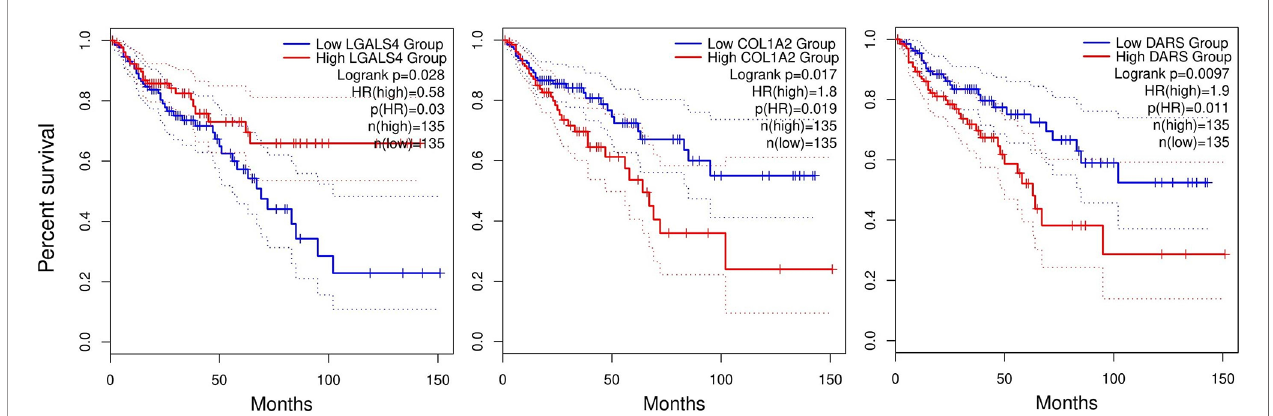
FIGURE 8 | Survival plots. Plots present the monthly survival rate of patients having high expression, red line, or low expression, blue line, of a speci fi c gene. Patients having high expression of LGALS4 had higher survival rates compared to patients having low expression of LGALS4. Contrary, patients having low expression of COL1A2 and DARS genes had higher survival